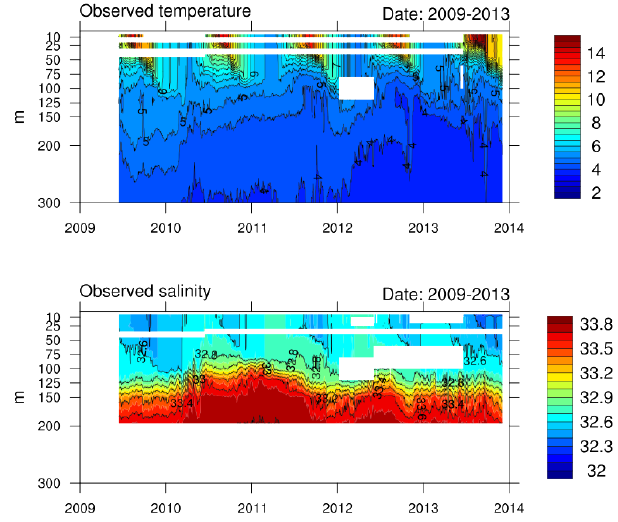
Figure 5. Temperature (top) and salinity (bottom) measured at the PAPA station covering the period